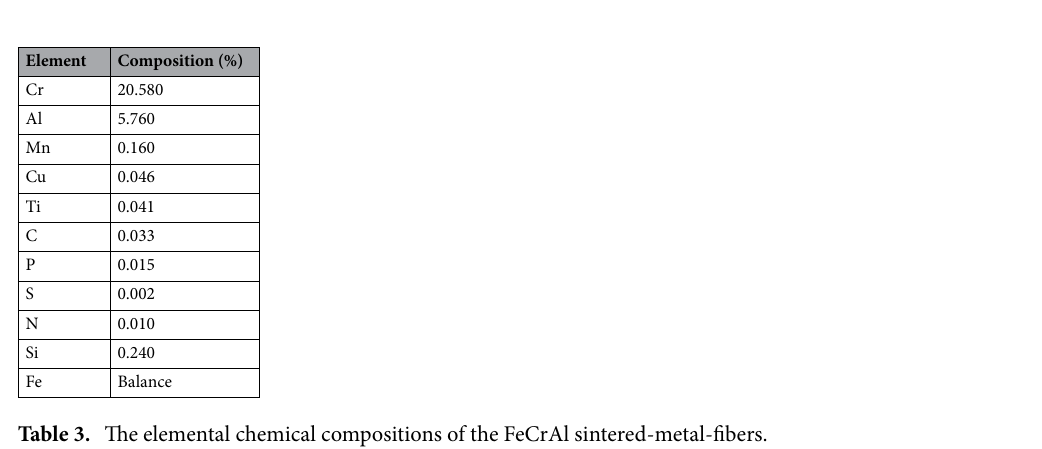
Table 3. The elemental chemical compositions of the FeCrAl sintered-metal-fibers.